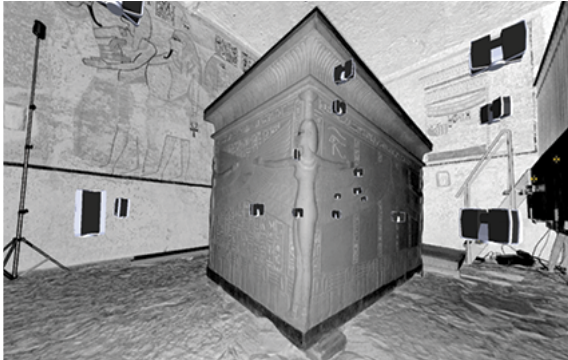
Figure 2: recording the surface of the burial chamber of the Tomb of Tutankhamen using 3D scanning, The Getty Conservation Institute and Carleton University Following Letellier (2011), CIMS, utilizing appropriate and suitable technology such as 3D scanning and photogrammetry, produced high-resolution ortho-corrected photographic elevations with millimetre resolution and accurate colour correction (see figures 1, 2 and 3).